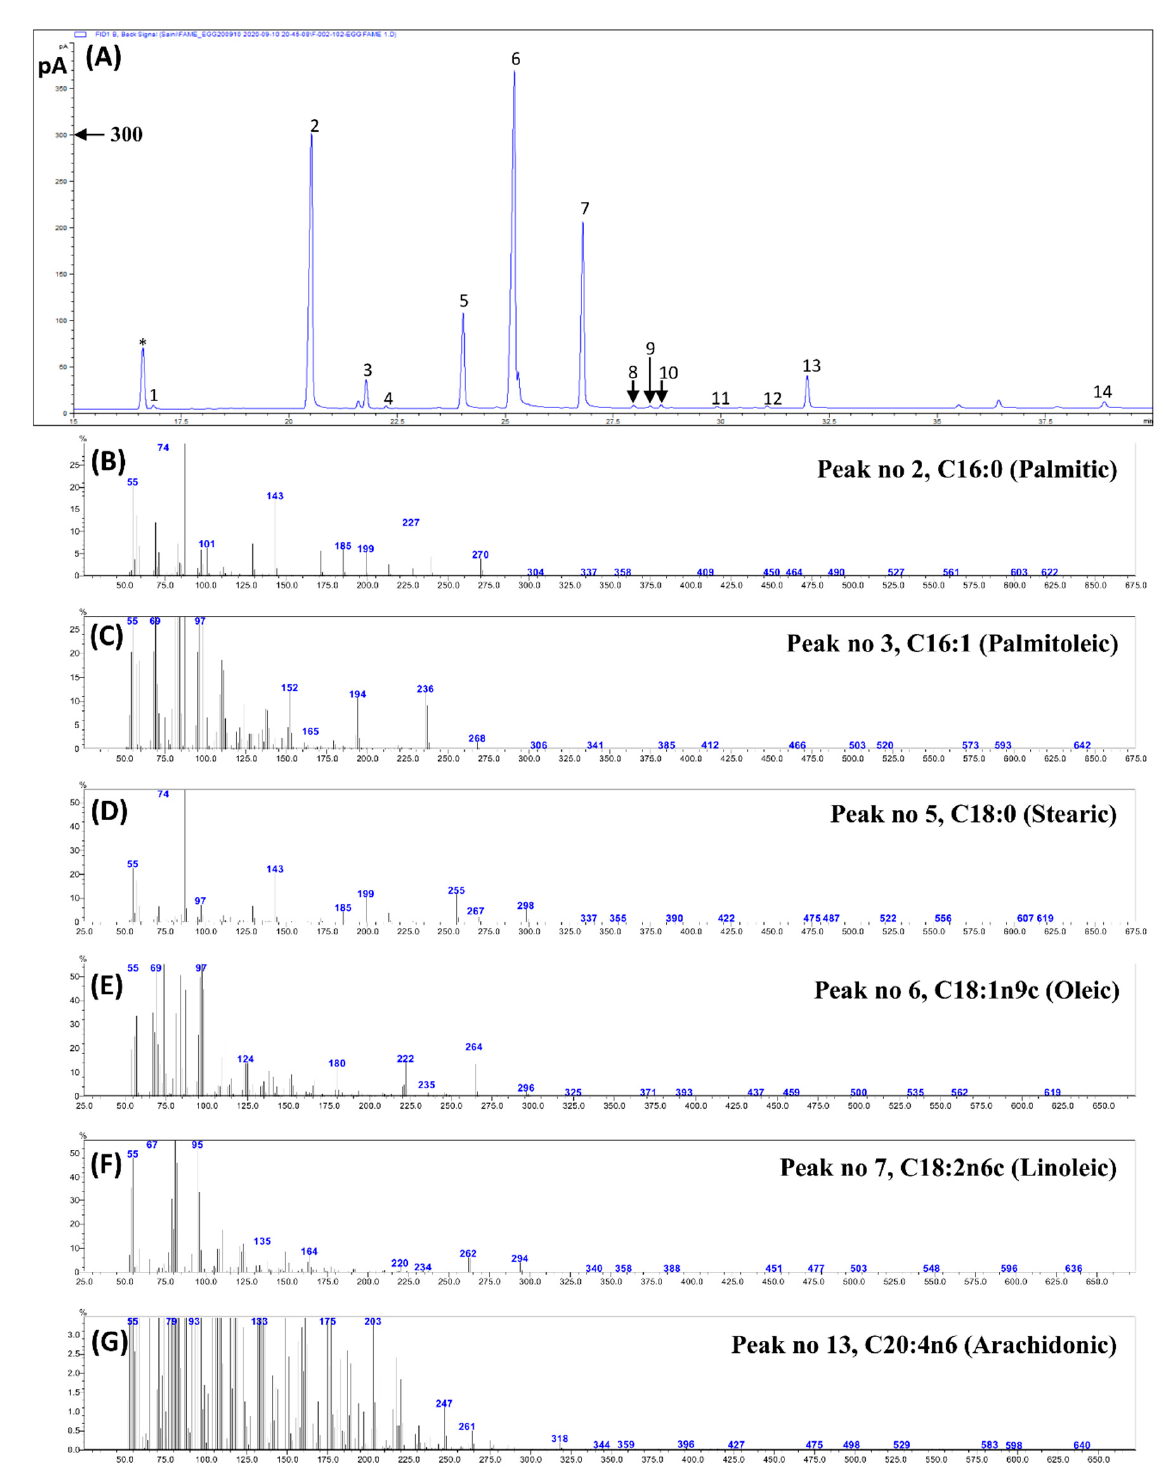
Figure 8. ( A ) Representative gas chromatography (GC)-flame ionization detection (FID) profiles of fatty acid methyl esters (FAMEs) from egg yolks. The peak numbers correspond to those used in Table 2. ( B–G ) The GC–mass spectrum of major FAMEs identified. The retention time of each identified FAMEs is given in Table 2.